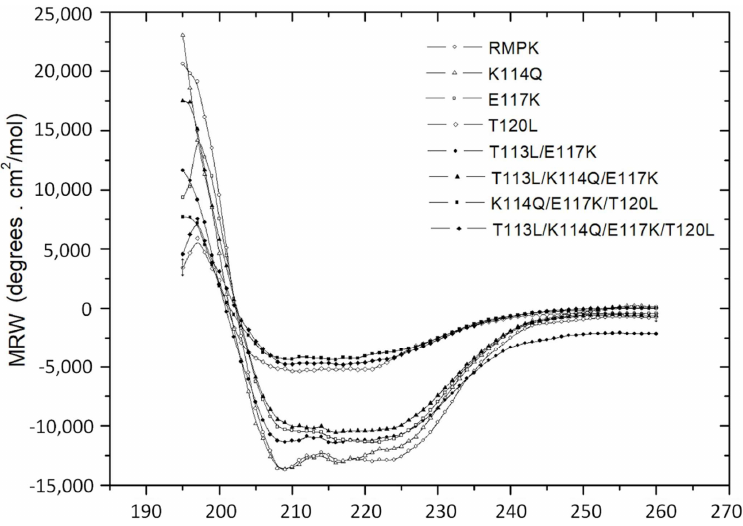
Figure 5. Far-UV CD spectra of WT-RMPK (  ) and of the RMPK mutants: E117K (  ), K114Q (  ), ) and of the RMPK mutants: E117K ( (cid:3) ), K114Q T113L/E117K (  ), T113L/K114Q/E117K (  ), T120L (  ), K114Q/E117K/T120L (  ) and T113L/K114Q/E117K/T120L (  ). The spectra were obtained in mixtures that contained each py- (cid:35) ( (cid:52) ), T113L/E117K ( • ), T113L/K114Q/E117K ( (cid:4) ), T120L ( (cid:53) ), K114Q/E117K/T120L ( (cid:78) ) and ruvate kinase at a concentration of 100 μg/mL in 25 mM phosphate buffer pH 7.0 at 25 °C in cell pathway of 0.1 cm. CD is expressed as θ MRW (mean residual weight ellipticity). T113L/K114Q/E117K/T120L ( (cid:72) ). The spectra were obtained in mixtures that contained each pyru- vate kinase at a concentration of 100 µ g/mL in 25 mM phosphate buffer pH 7.0 at 25 ◦ C in cell pathway of 0.1 cm. CD is expressed as θ MRW (mean residual weight